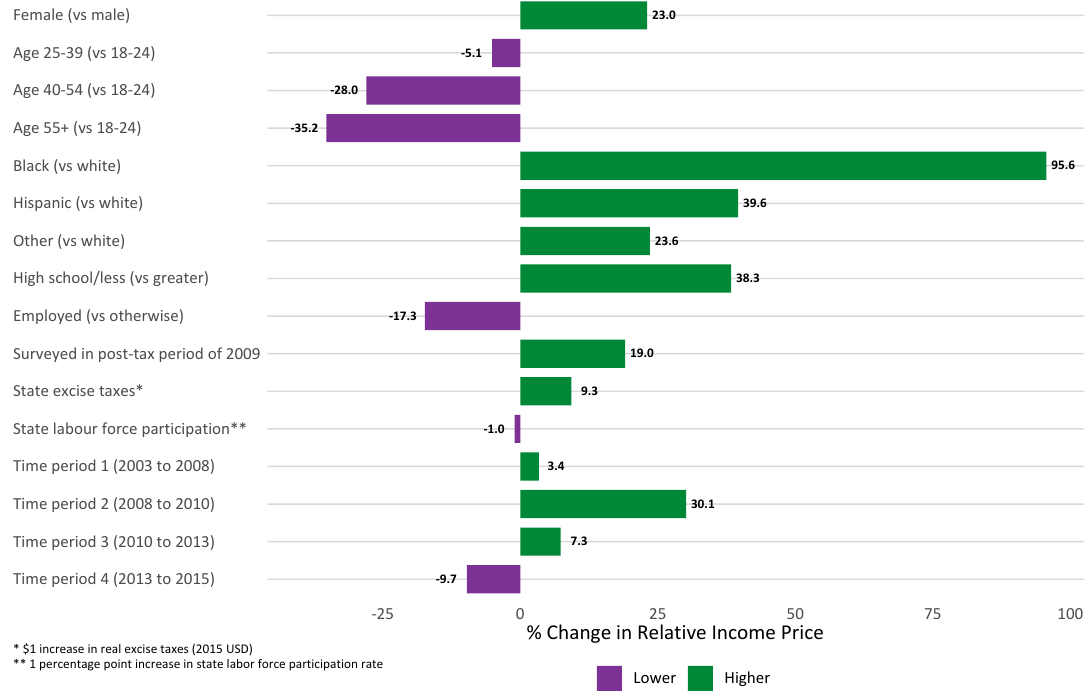
Figure 1. Percent change in RIP among US smokers from 2003 to 2015 (longitudinal LME regression, n =